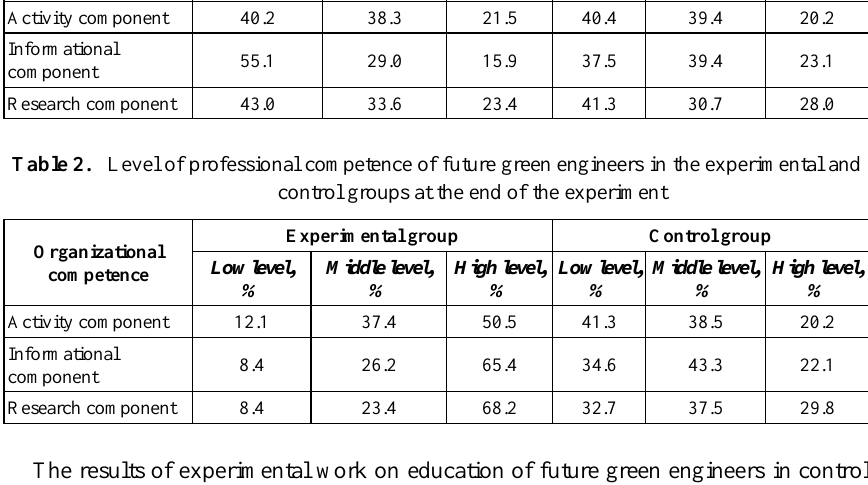
Table 1. Level of professional competence of future green engineers in the experimental and control groups at the beginning of the experiment Organizational competence